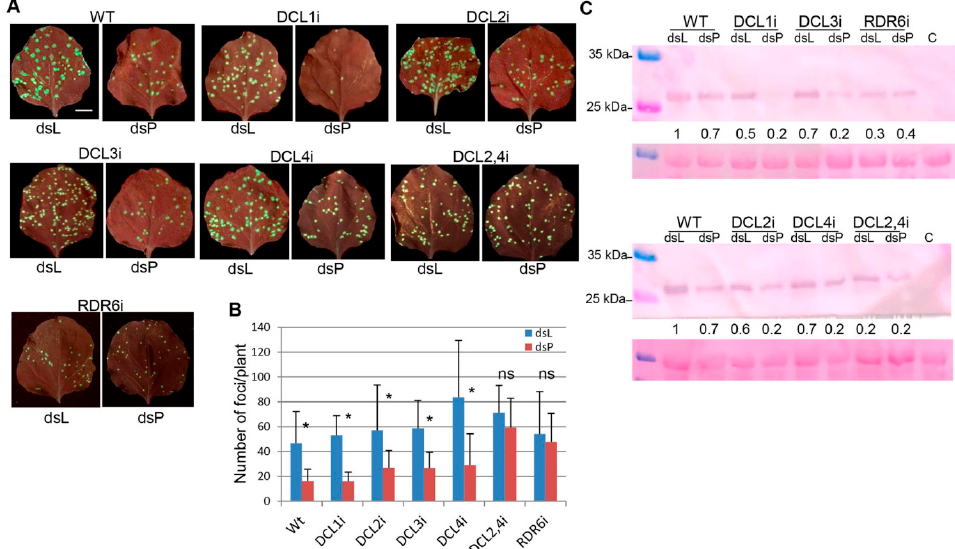
Figure 6. Role of DCL and RDR6 proteins in RNAi induced by topically applied dsRNA. Wt and DCL1i, DCL2i, DCL3i, DCL4i, DCL2/4i and RDR6i mutant lines were inoculated with mixtures of PVX-GFP and either naked dsPVX (dsP) or dsL. ( A ) Representative inoculated leaves were examined under UV light at 4 days post-inoculation (dpi). Scale bar denotes 1 cm. ( B ) Mean values ± standard deviations of infection foci per plant counted at 4 dpi on 2 inoculated leaves for a total of 10 plants per treatment. Asterisks indicate significant differences between treatments (Student’s t-test, p < 0.05). Ns: not significant. Data presented were collected from two independent experiments. ( C ) Western blot analysis of plant extracts derived from inoculated leaves at 4 dpi, using antibodies against PVX CP. Lane C corresponds to the extract from a non-infected plant. The lower panel shows the Ponceau S-stained membrane after blotting, as a control of loading. The intensity of each PVX CP band was quantified by densitometry analyses, and normalized to the Ponceau S-stained band. Protein levels in Wt leaves treated with dsL are given the value of 1 and other data were calculated relative to this value. * significant.